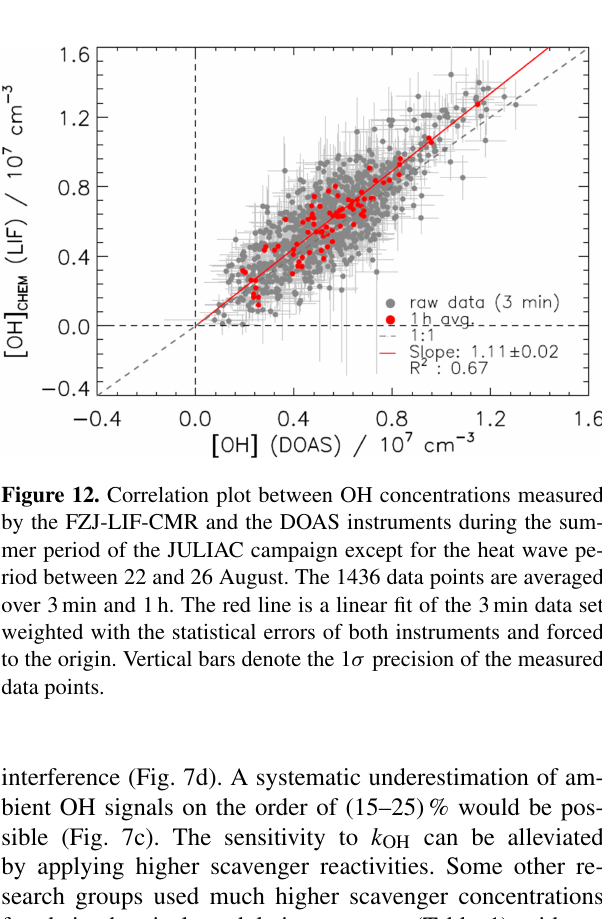
Figure 11. Time series of OH concentrations measured by LIF-CMR (red line) and DOAS (blue line) during the summer period of the JULIAC campaign. The green line shows the equivalent OH concentration of the interference signal in the LIF system. All data points are 30min averages. Vertical dashed lines denote midnight. Grey-shaded areas indicate when the chamber roof was closed. Data gaps occurred when measurements were stopped for calibrating instruments.